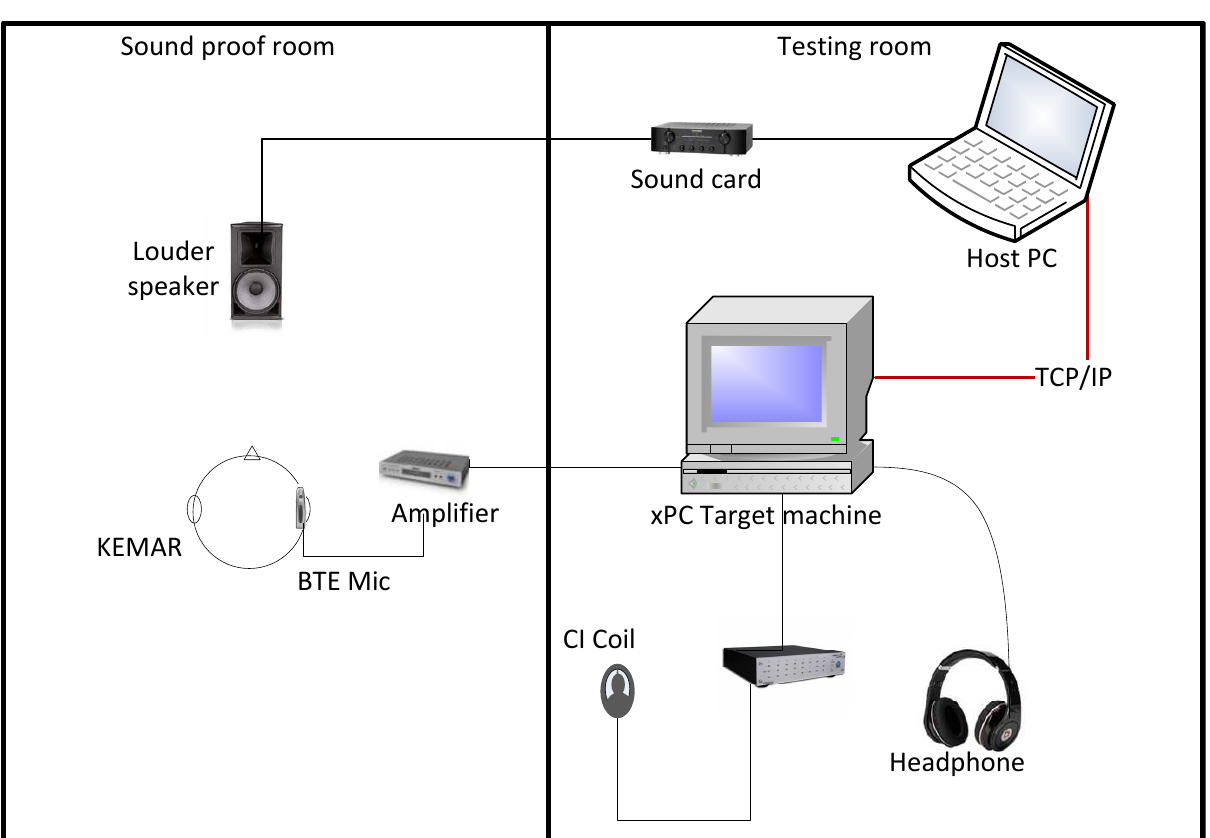
Figure 3. The experimental setup, including the overall architecture of the host-target HIL real-time cochlear implant (CI) stimulation system. The left and right parts of the figure correspond to the the sound proof room and testing room,